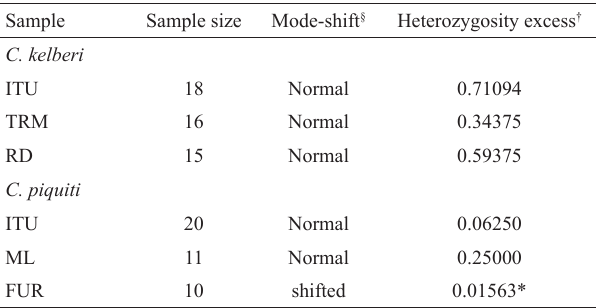
Table 3. Bottleneck tests. Results of two methods assessing